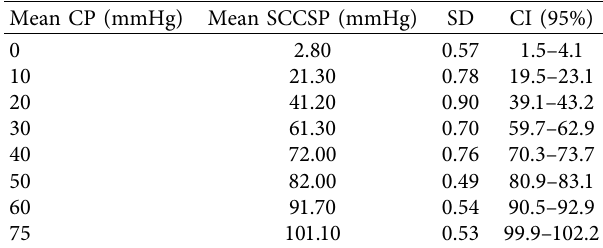
∗∗ Correlation is signifcant at the 0.01 level (two-tailed). CP, cuf pressure; SCCSP, skin-cast contact surface